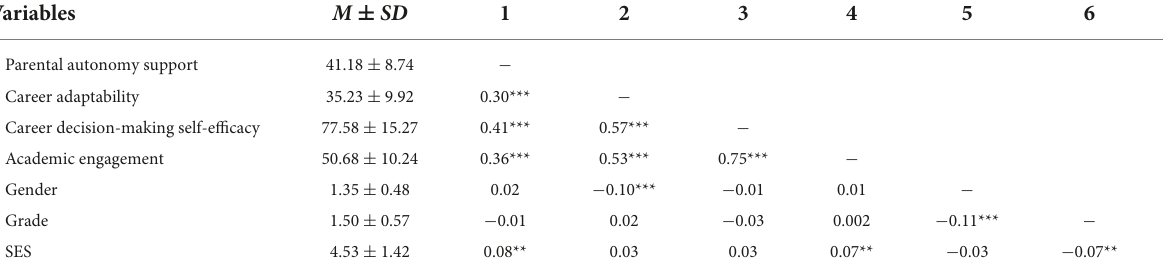
TABLE 2 Descriptive statistics of each variable and the results of their correlation analysis.